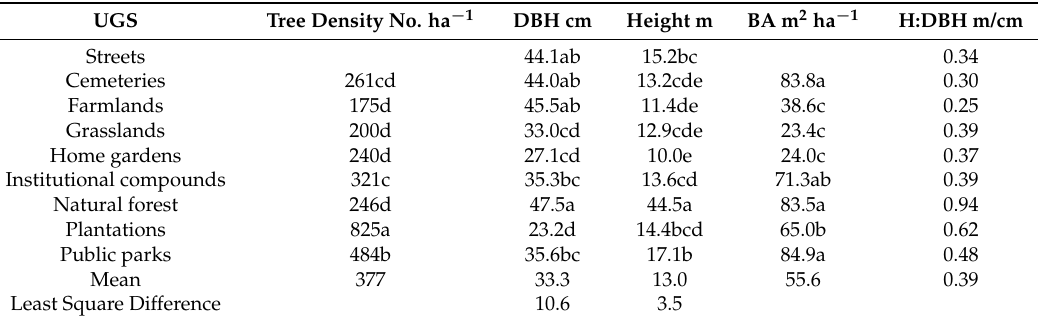
Table 3. The structural attributes of the urban forest in Kumasi. Numbers in the same column followed by the same letter are not significantly different at p = 0.05.